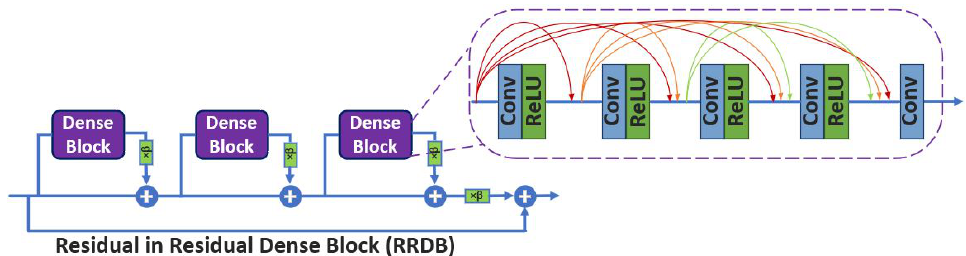
Figure 4. The dense block and the simplified residual-in-residual dense block, β =